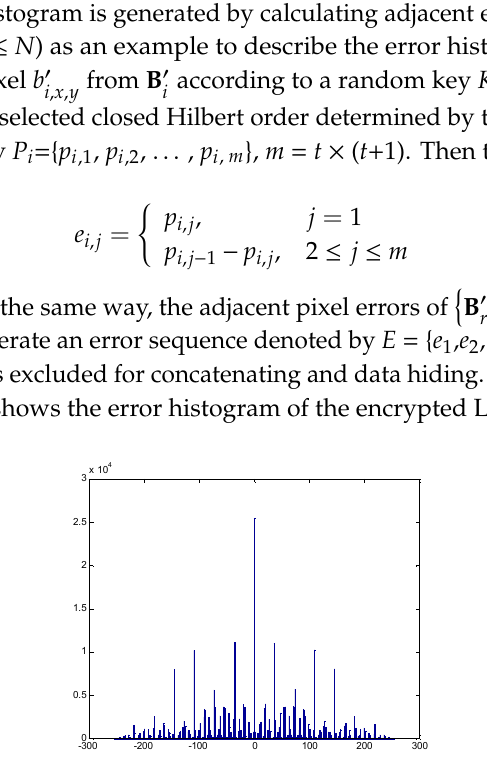
Figure 4. Error histogram of the encrypted Lena.